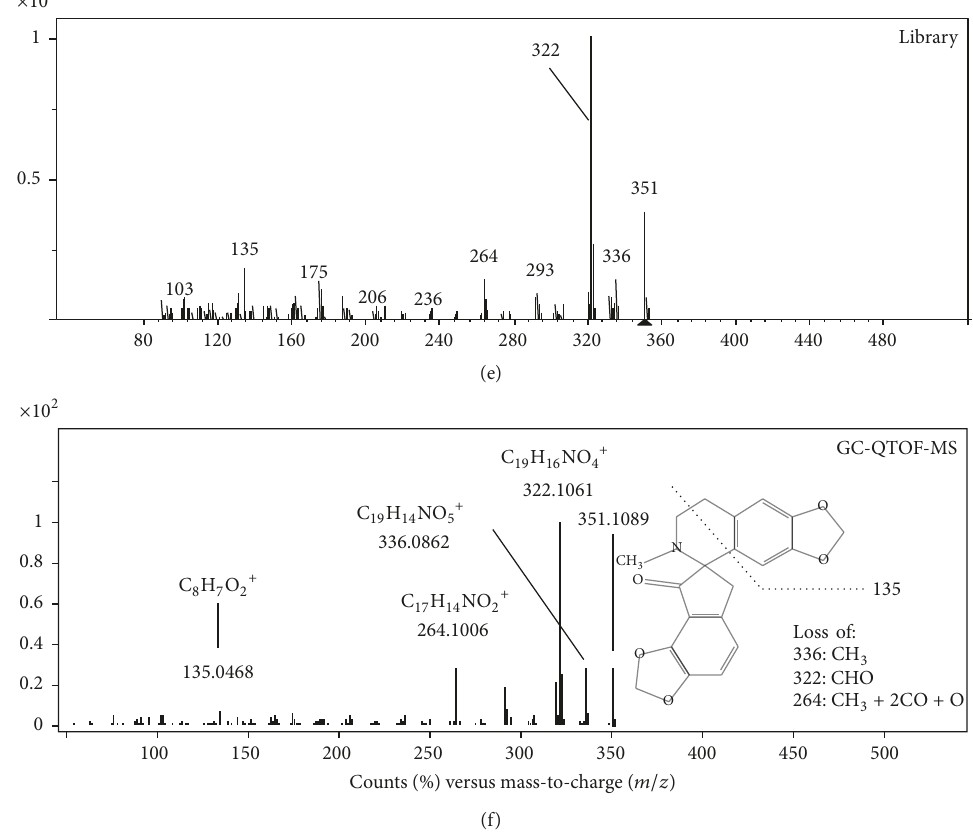
Figure 2: Fragmentation patterns of stylopine ((a) and (b)), protopine ((c) and (d)), and fumariline ((e) and (f)) described in the library and determined by GC-QTOF-MS,